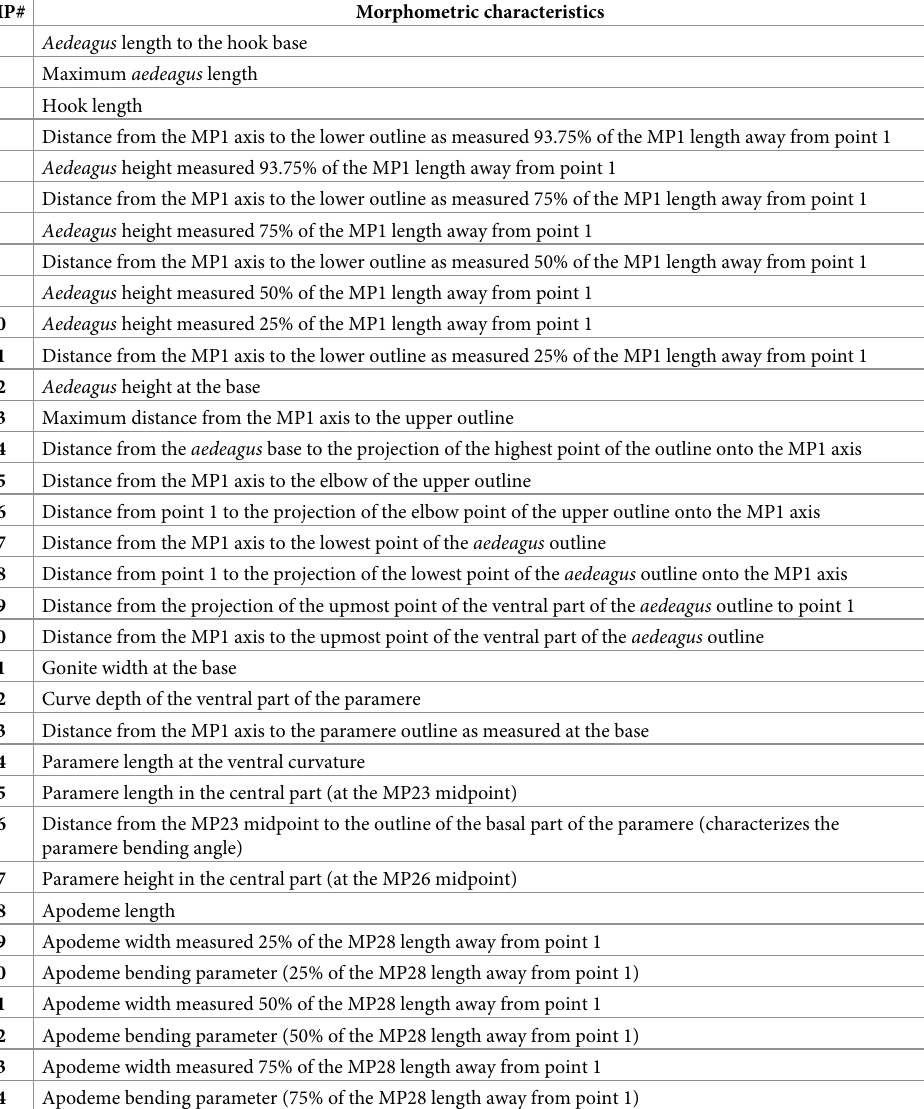
Table 1. Description of the morphometric